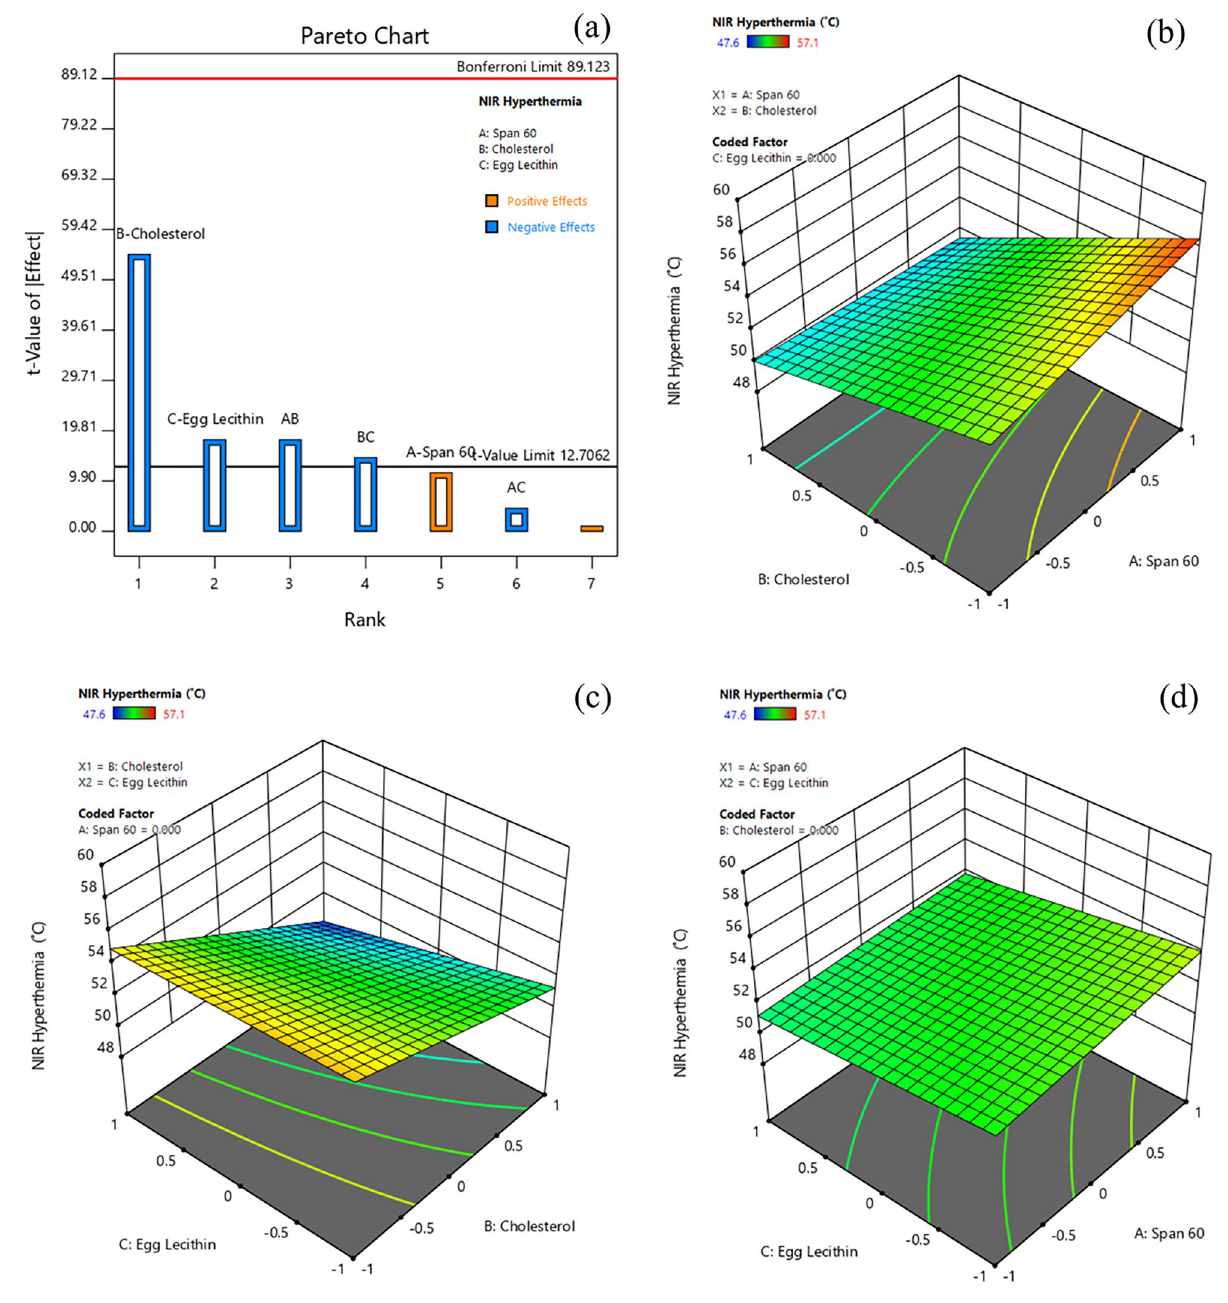
Figure 7. Effect of formulation variables ( a ) Pareto chart of NIR-Hyperthermia, ( b ) Span60*Cholesterol on NIR-Hyperthermia, ( c ) Cholesterol*Egg Lecithin on NIR-Hyperthermia, ( d ) Span60*Egg Lecithin on NIR- Hyperthermia [Design-Expert version